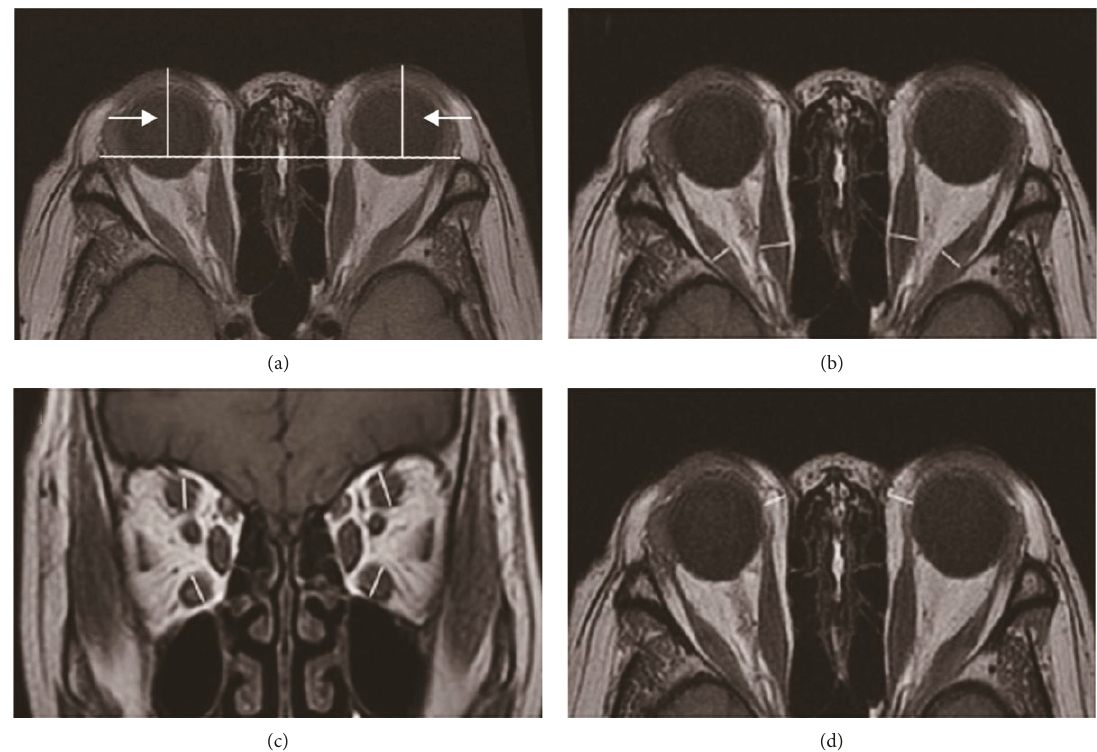
Figure 1: Methods for ophthalmic parameter measurement. (a) The values of exophthalmos. (b) The horizontal diameters of the medial and lateral rectus muscles. (c) The vertical diameters of the superior and inferior rectus muscles. (d) The thickness of fatty